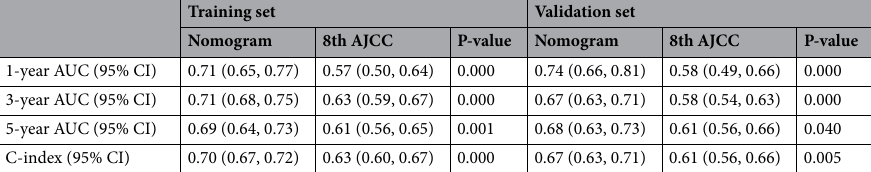
Training set Validation